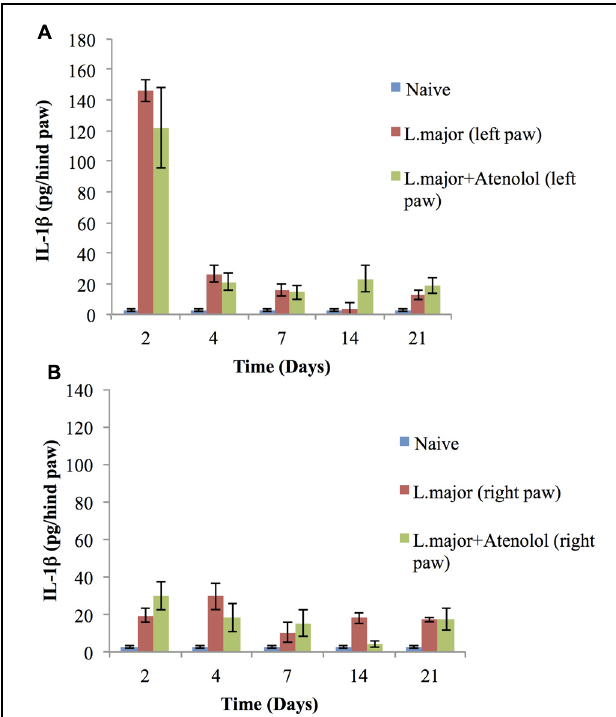
FIGURE 7 | Effect of the daily i.p. injection of atenolol on the level of IL-l β in the paws of mice infected with high dose (4 × 10 6 promastigotes/50 μ l nutrient broth medium/left hind paw) of L. major : (A) left (infected) paws (B) right (non-infected) paws. Mice were injected with 2.0 mg/kg of atenolol (i.p.) for 7 consecutive days (and the levels of IL-l β were assessed at days 2, 4, 7, 14, and 21 post-infection. Each result is the mean of 5 mice ± SEM and the degree of significance was calculated with reference to atenolol non-treated mice.